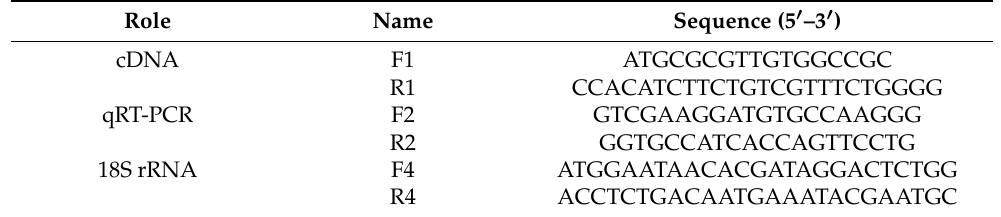
Table 1. Primers used in this